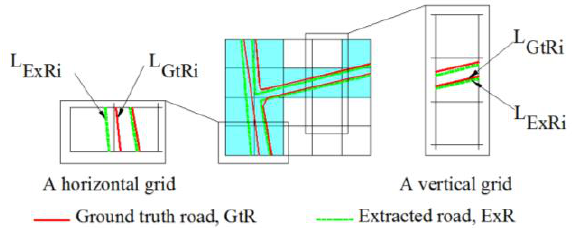
Figure 8. Illustration of determining a pair of road edge segments (L GtRi and L ExRi